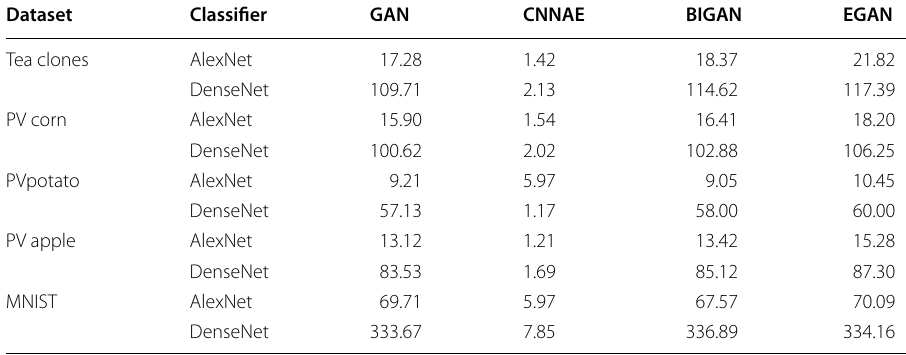
Table 4 Comparison of running time between EGAN and other feature learning methods